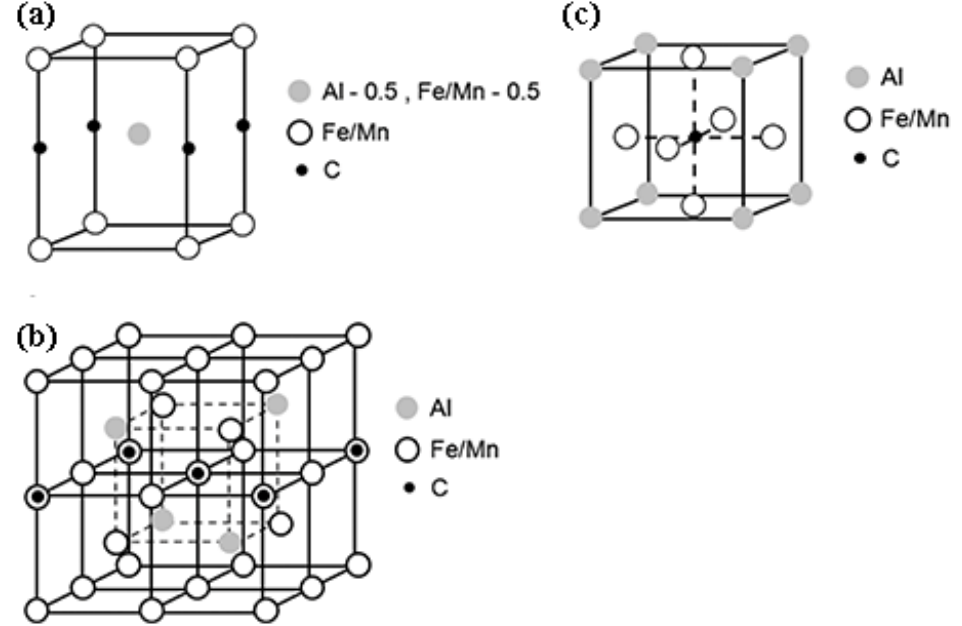
Figure 1. Schematic visualization [18] of the supercell of ( a ) B2 , ( b ) D0 3 , ( c ) κ ’-carbide. (Reproduced with permission from [18]. Copyright 2013 Elsevier).